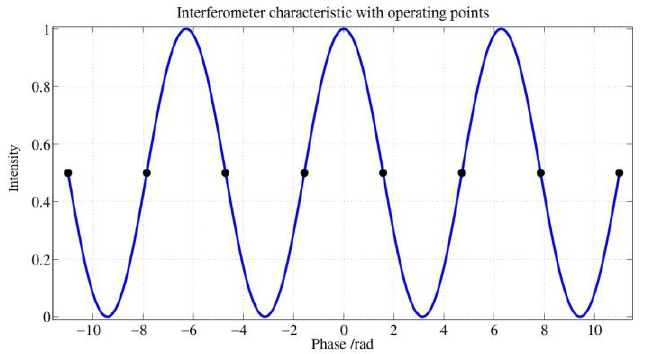
Figure 11. Sagnac Interferometer characteristic with operating points showing the relative intensity over the Sagnac phase in radiants.